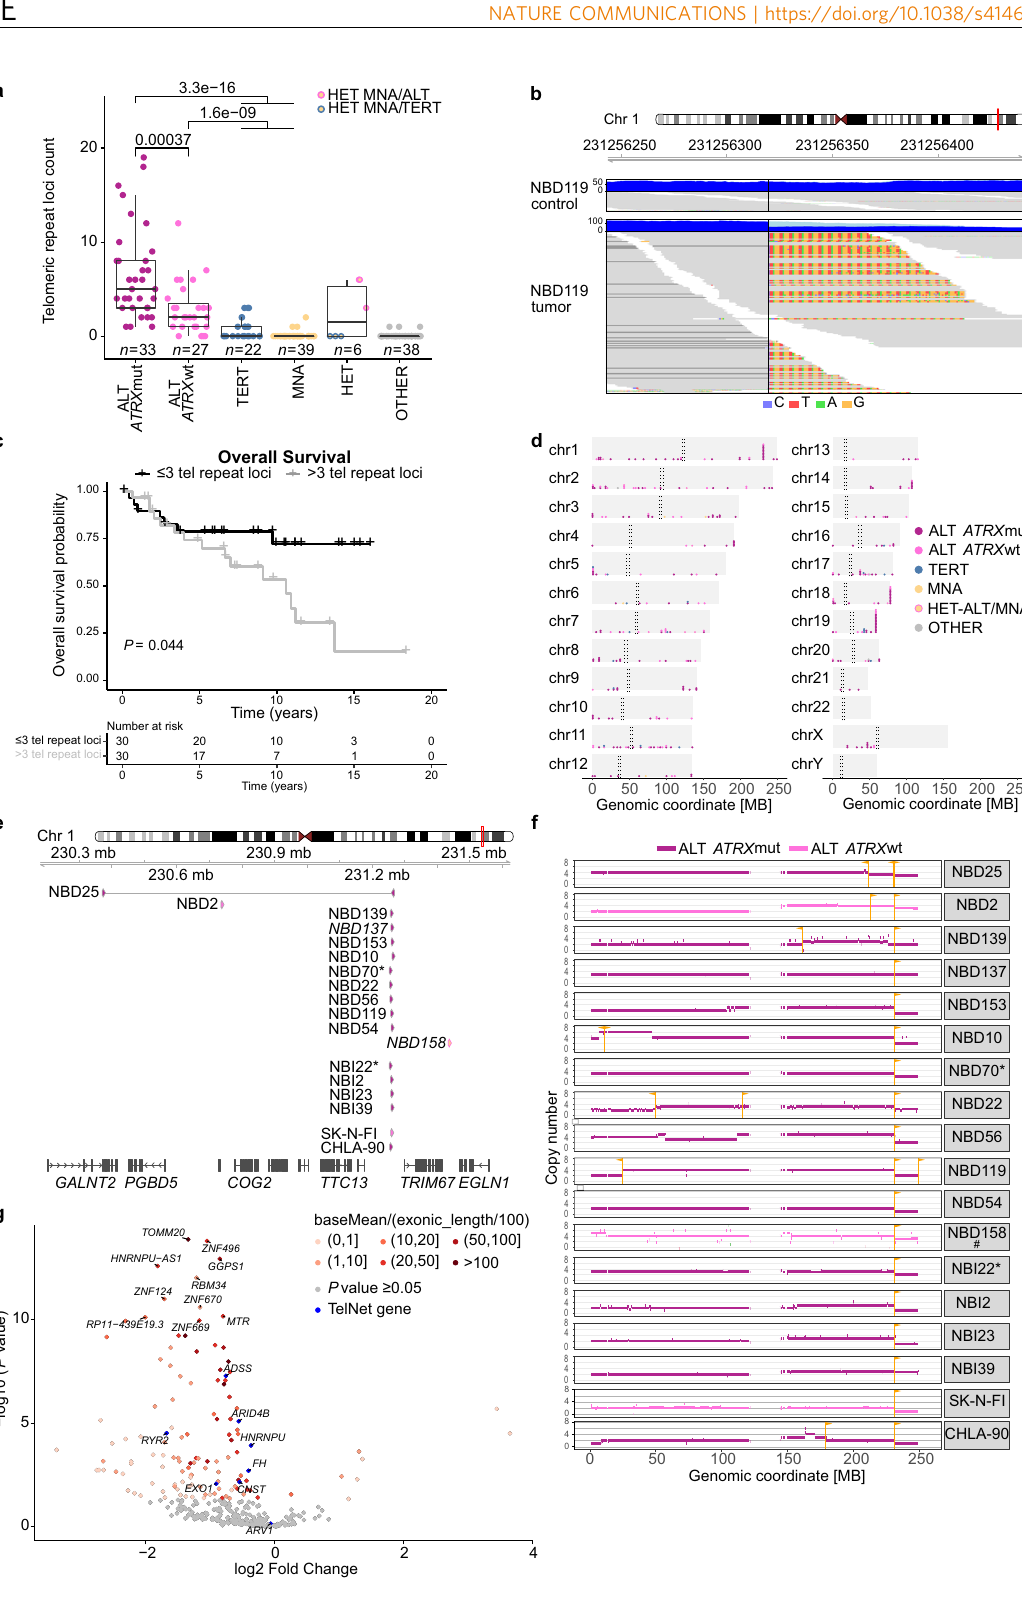
therapy resistance mechanism. Analysis of matching primary/ relapse pairs revealed a gain of ALT or outgrowth of an ALT- positive subclone in the relapse tumor. Taken together, a revised therapy concept based on a better molecular under- standing of this subtype and considering ALT-speci fi c vulner- abilities is urgently needed for these